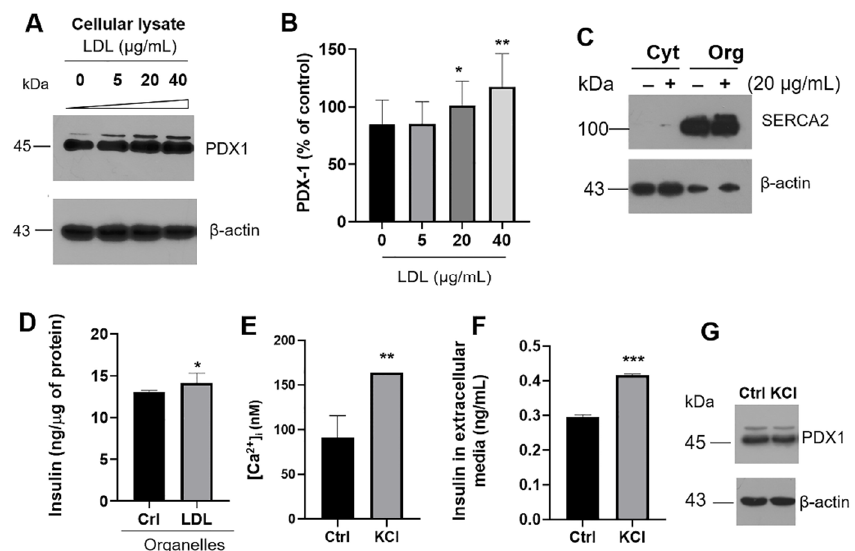
Figure 3. LDL modulates the extracellular insulin concentration through a transcriptional mecha- nism. ( A ) PDX-1 expression under LDL treatment (0–40 µg/mL). ( B ) Densitometry analysis of PDX-